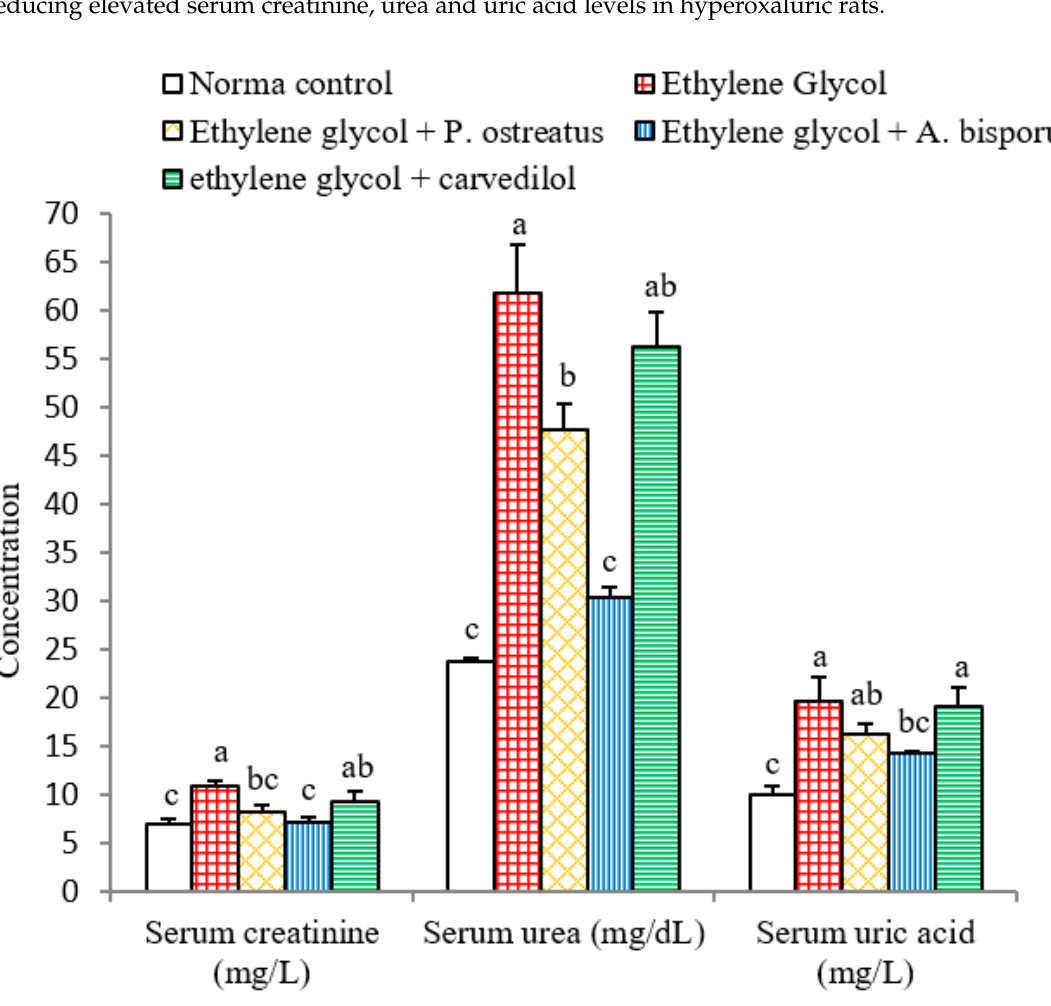
Figure 5. Effect of P. ostreatus and A. bisporus aqueous extracts and carvedilol on levels of serum parameters related to kidney function of ethylene glycol-administered rats. For each parameter, means which share the same letter(s) are not significantly different.